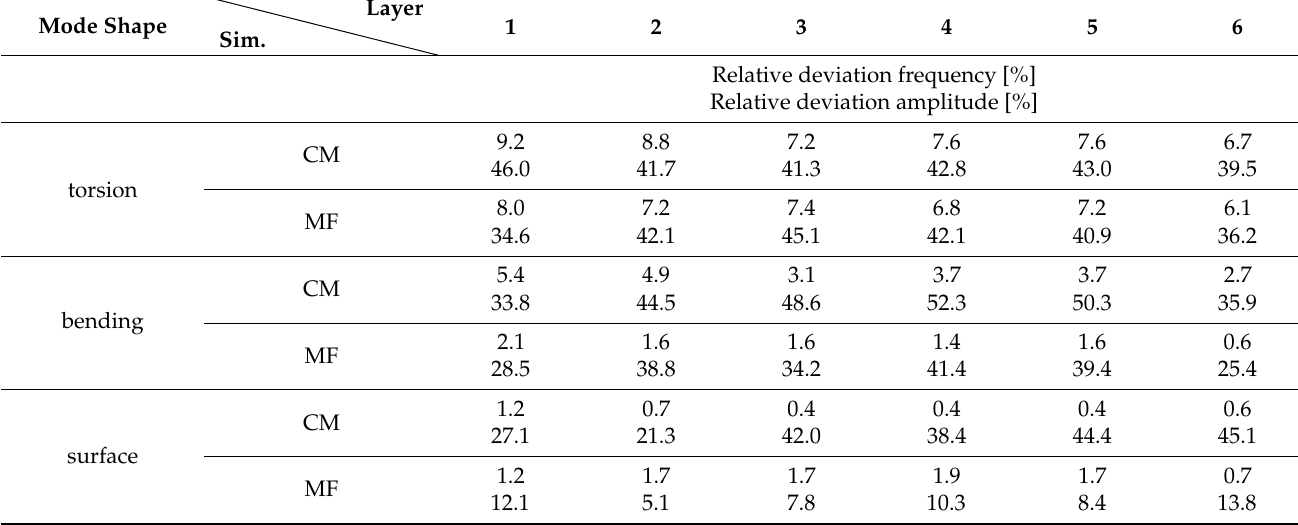
Table 9. Relative deviation of frequency and amplitude between simulations and experiment of the PA66GF50 engine bracket for identified mode shapes with fiber orientation from CM and MF